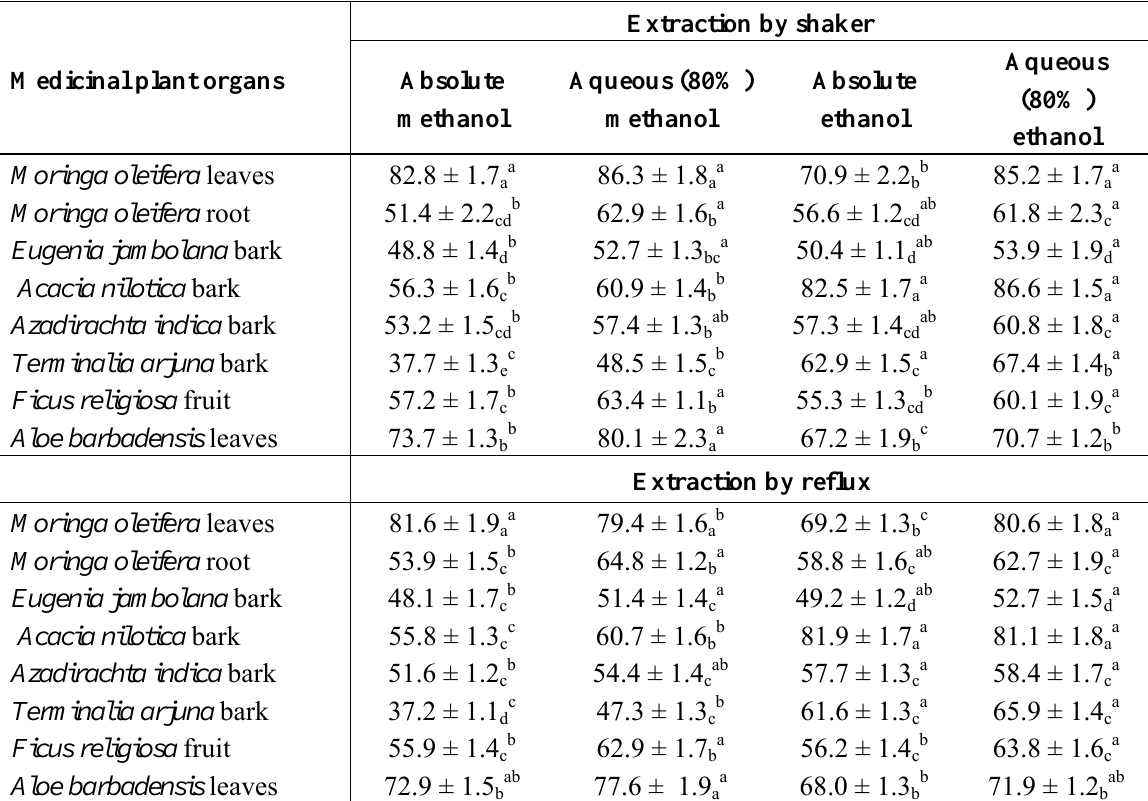
Table 5. Effects of extracting solvent/technique the DPPH . scavenging activity (%) of different medicinal plant